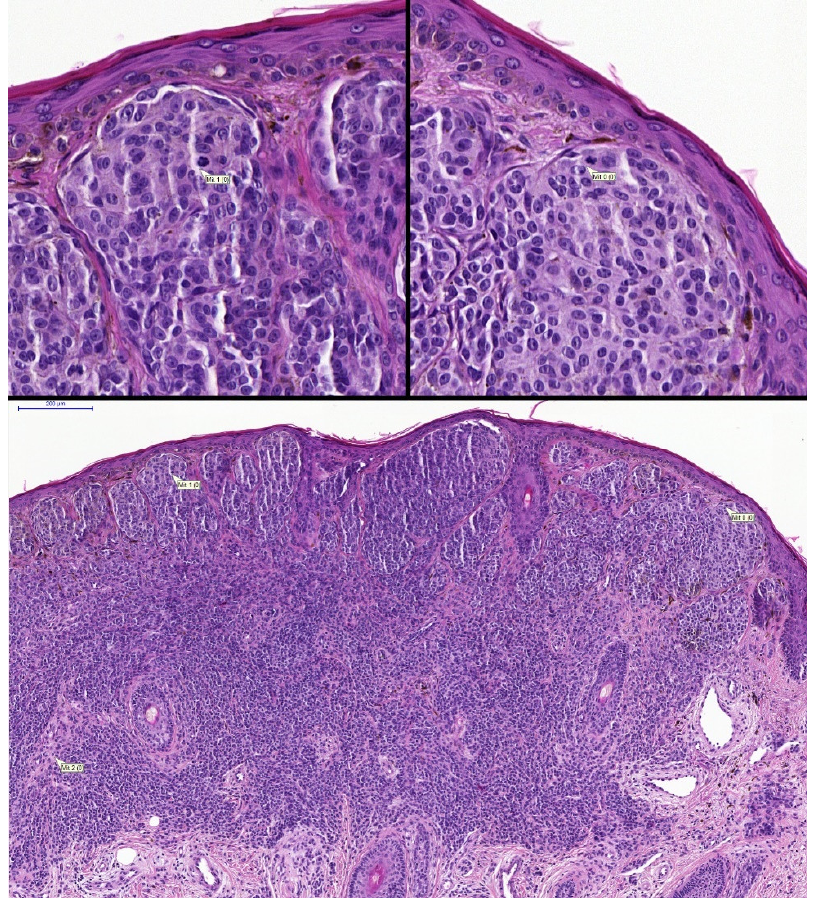
Figure 5. (row above ×400, row below ×100 magnification). Example of nevoid melanoma with two annotated correct lesional dermal mitoses. Case 71; two pathologists changed the diagnosis from benign to malignant with the aid of the algorithm.